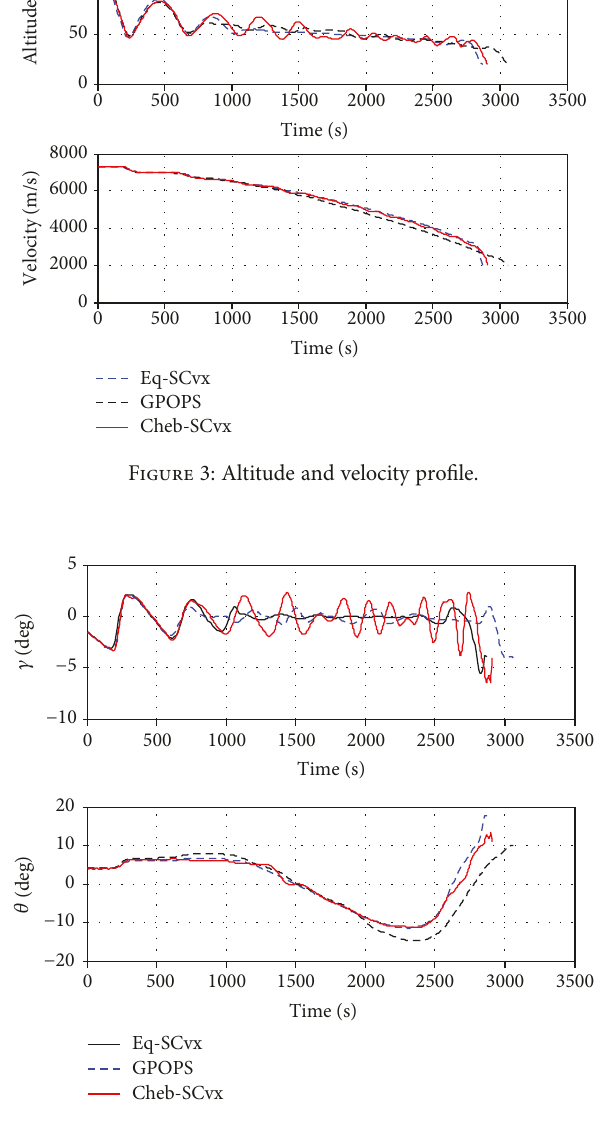
Figure 4: Flight path angle and heading angle histories.